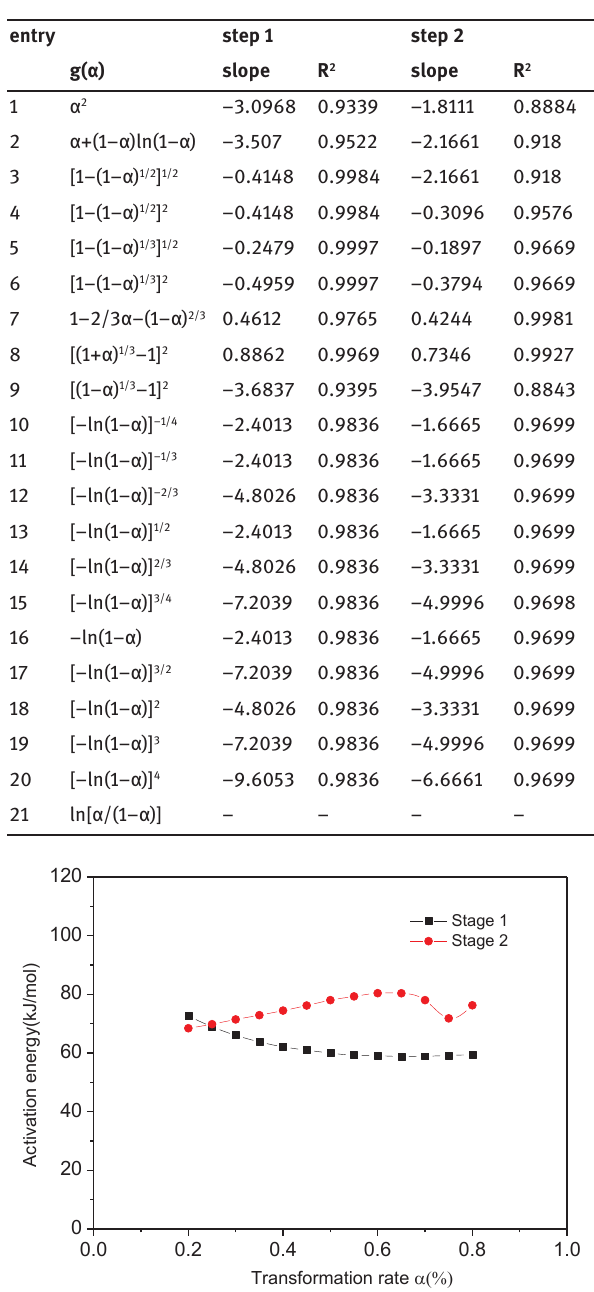
Figure 4: Line chart for thermal decomposition of NPL-10.